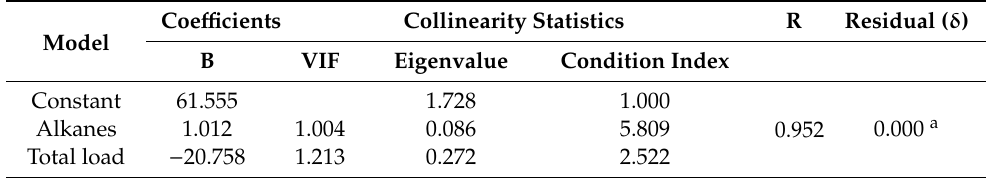
Figure 3. The principle components analysis (PCA) load diagram accorded to the relative concentrations of cuticle compounds in poplar leaves.